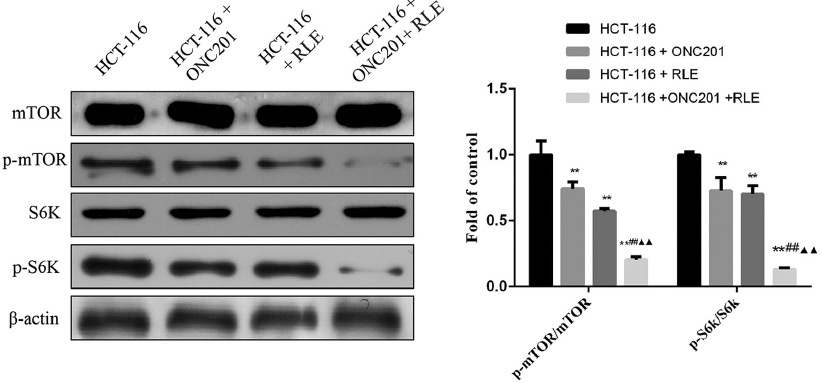
Figure 5. Effect of RLE and ONC201 co-treatment on p-mTOR/mTOR and p-S6K/S6K protein expression levels in HCT116 cells. * P < .05, ** P < .01 vs. the HCT116 group; # P < .05, ## P < .01 vs. the HCT116 + ONC201 group; ▲ P < .05, ▲▲ P < .01 vs. the HCT116 + RLE group. RLE, raw lacquer